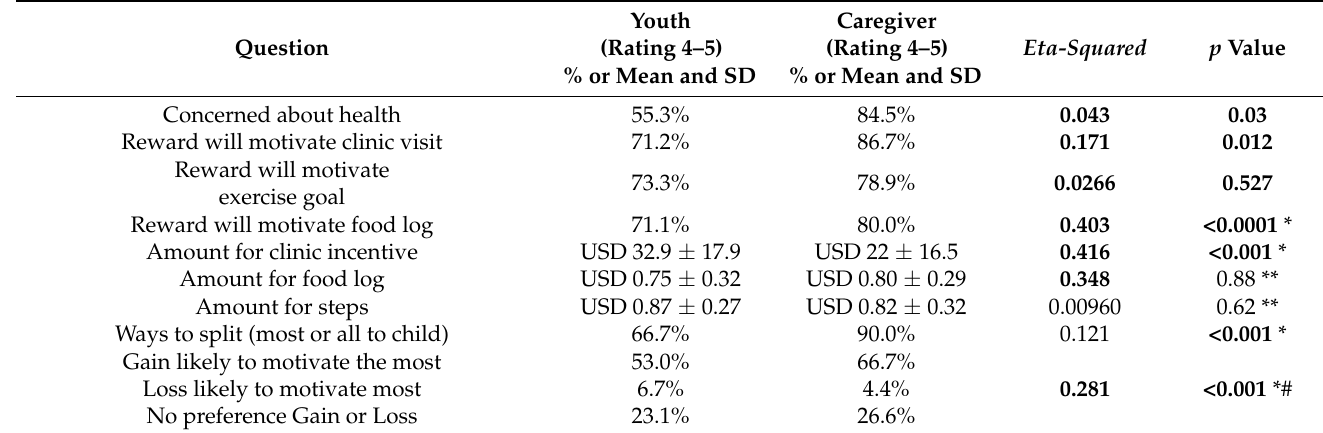
Table 5. Attitudes about incentives and overall health.